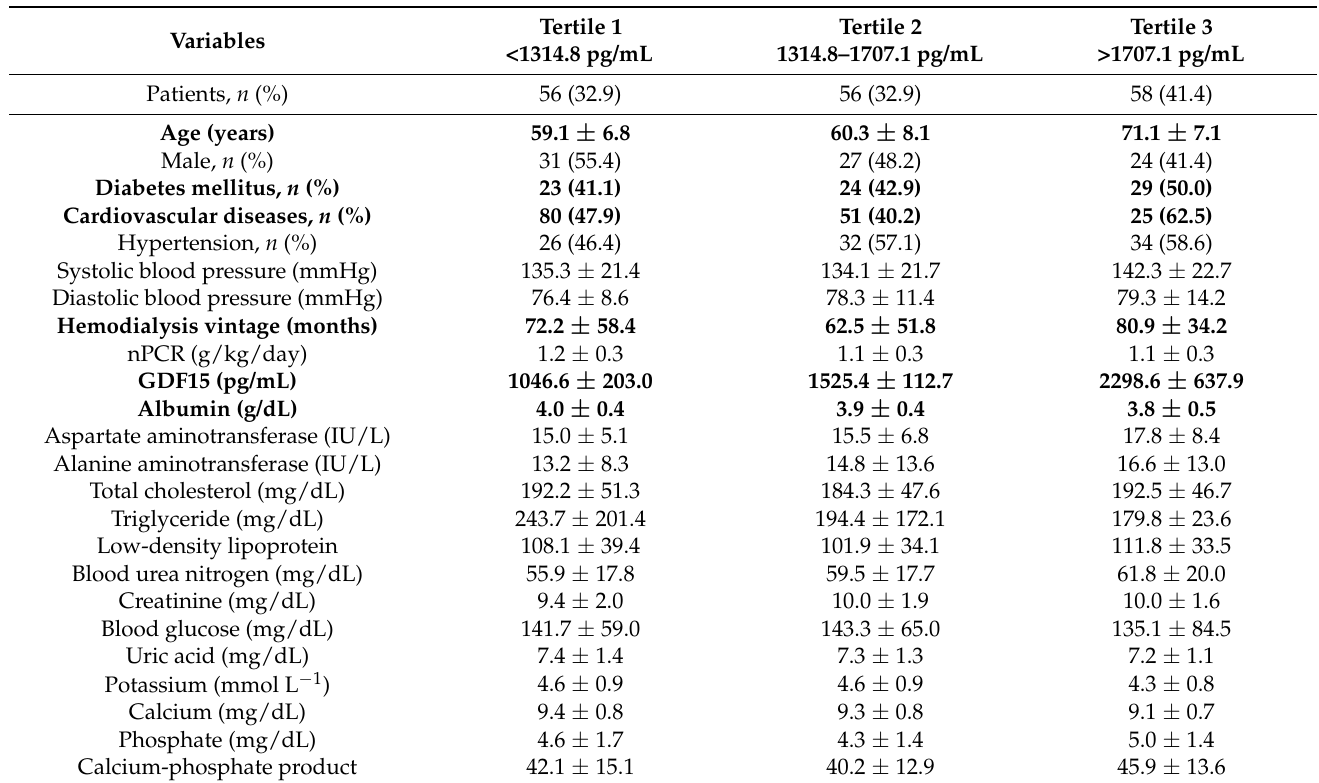
Table 1. Age, diabetes mellitus, cardiovascular diseases, hemodialysis vintage, and albumin differ significantly in the comparisons of baseline bio-clinical characteristics according to GDF15